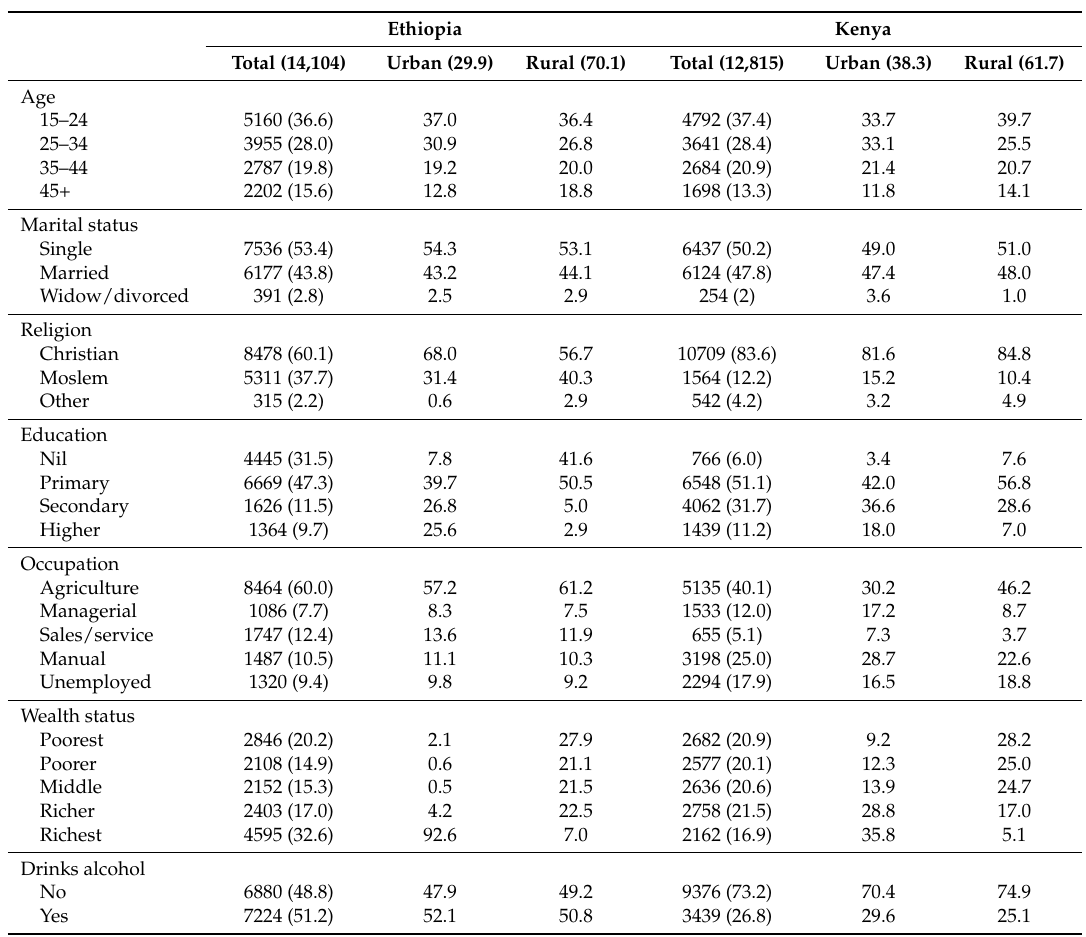
Table 3. Sociodemographic characteristics of the sample